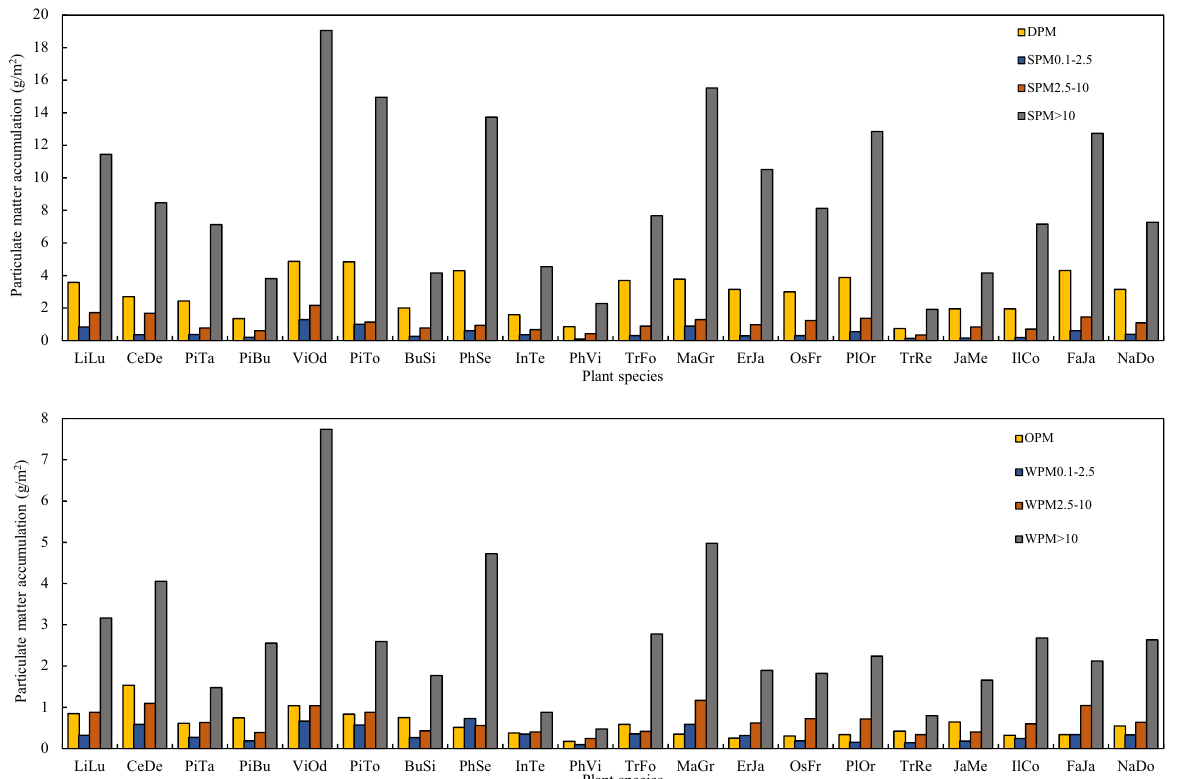
Figure 5. The mass of PM per unit green area eluted by water and brushing (SPM), chloroform and brushing (WPM) within different diameter classes (diameter > 10 µ m, 2.5–10 µ m, 0.1–2.5 µ m), water-soluble (DPM), and organic-soluble (OPM) particulate matter retained on the investigated leaves. Table 1. The retention efficiency (AE) of the investigated plant species in retaining surface PM (SPM) within different